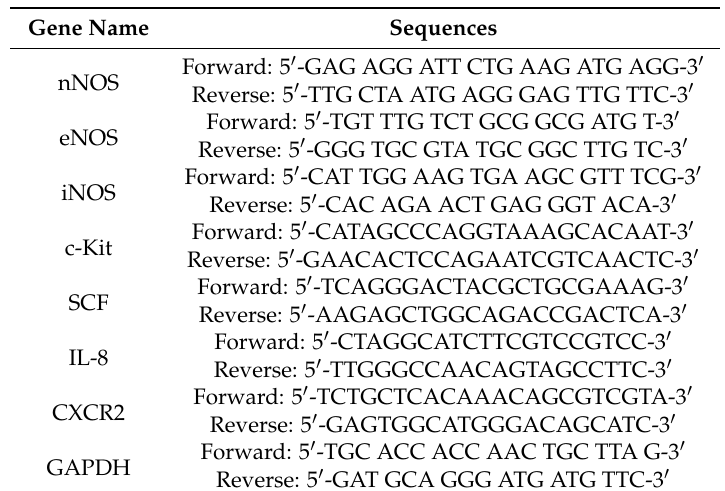
Table 5. Sequences of primers